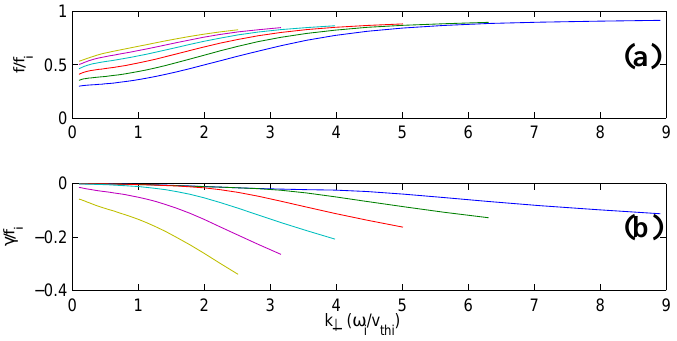
Fig. 9. Solutions from WHAMP code for kinetic Alfv´en waves. (a) shows the real part and (b) shows the imaginary part of frequency with k k =0.1 (blue), k k =0.13 (green), k k =0.16 (orange), k k =0.2 (aqua), k k =0.25 (magenta), k k =0.32 (yellow) normalized to ion cyclotron frequency at B =85nT as a function of k ⊥ . Table 2. Properties of Kinetic Alfv´en waves (KAW) when damping becomes 20% of the real frequency (calculated from WHAMP model with Maxwellian electron and proton species with B =85nT). Columns list parallel and perpendicular wave numbers and wave lengths, real frequency and wave propagation angle with respect to magnetic field. Ion cyclotron radius, r thi , used here is 22km. KAW k k ( 1 /r thi ) k ⊥ ( 1 /r thi